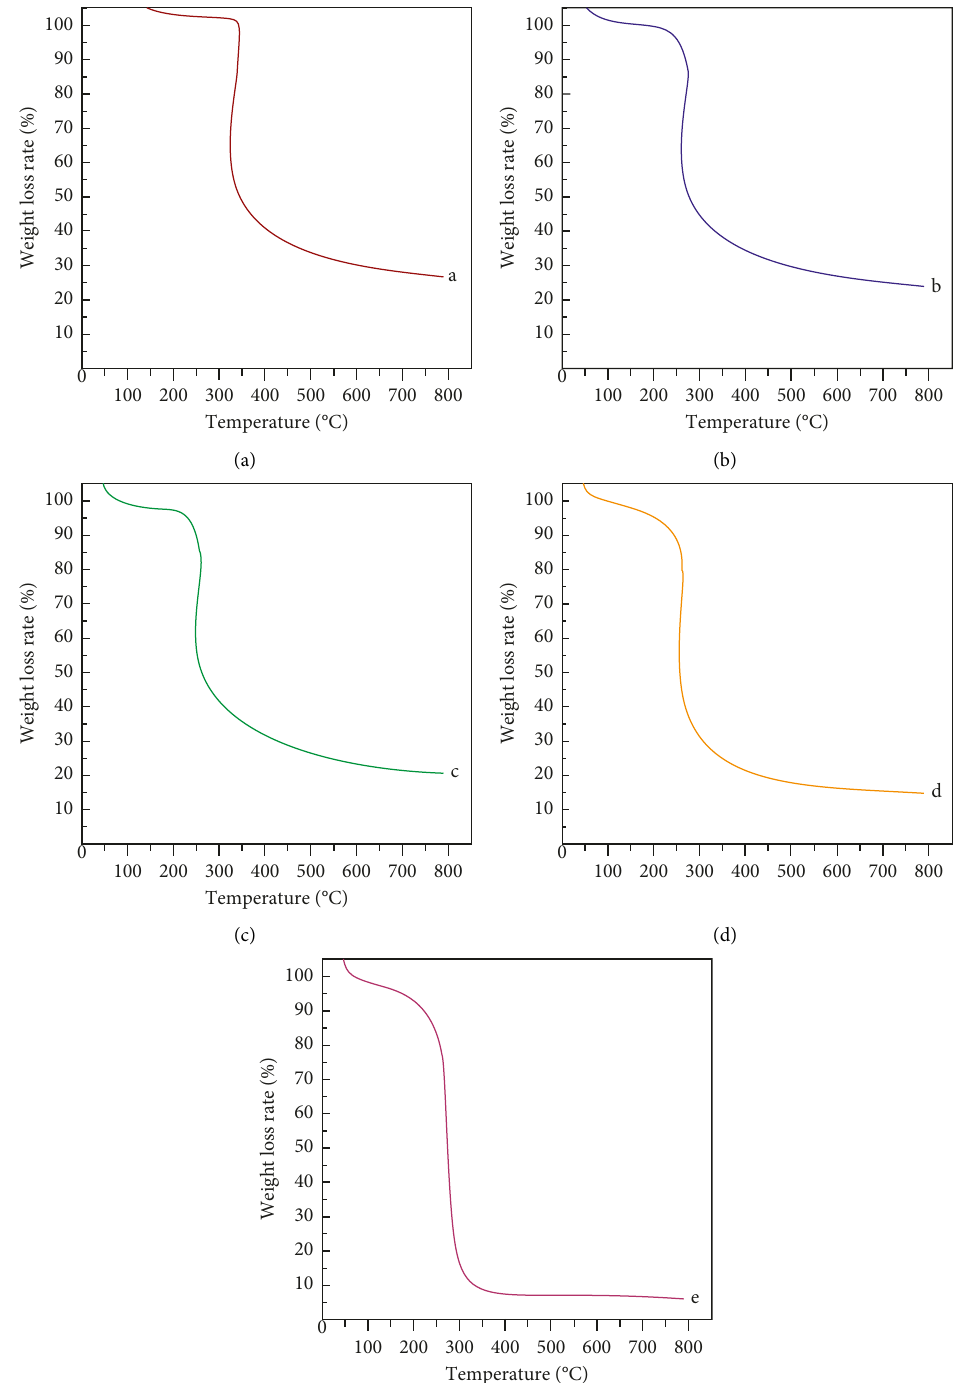
Figure 7: TG profiles of SF-collagen/PLLA composite nanofiber